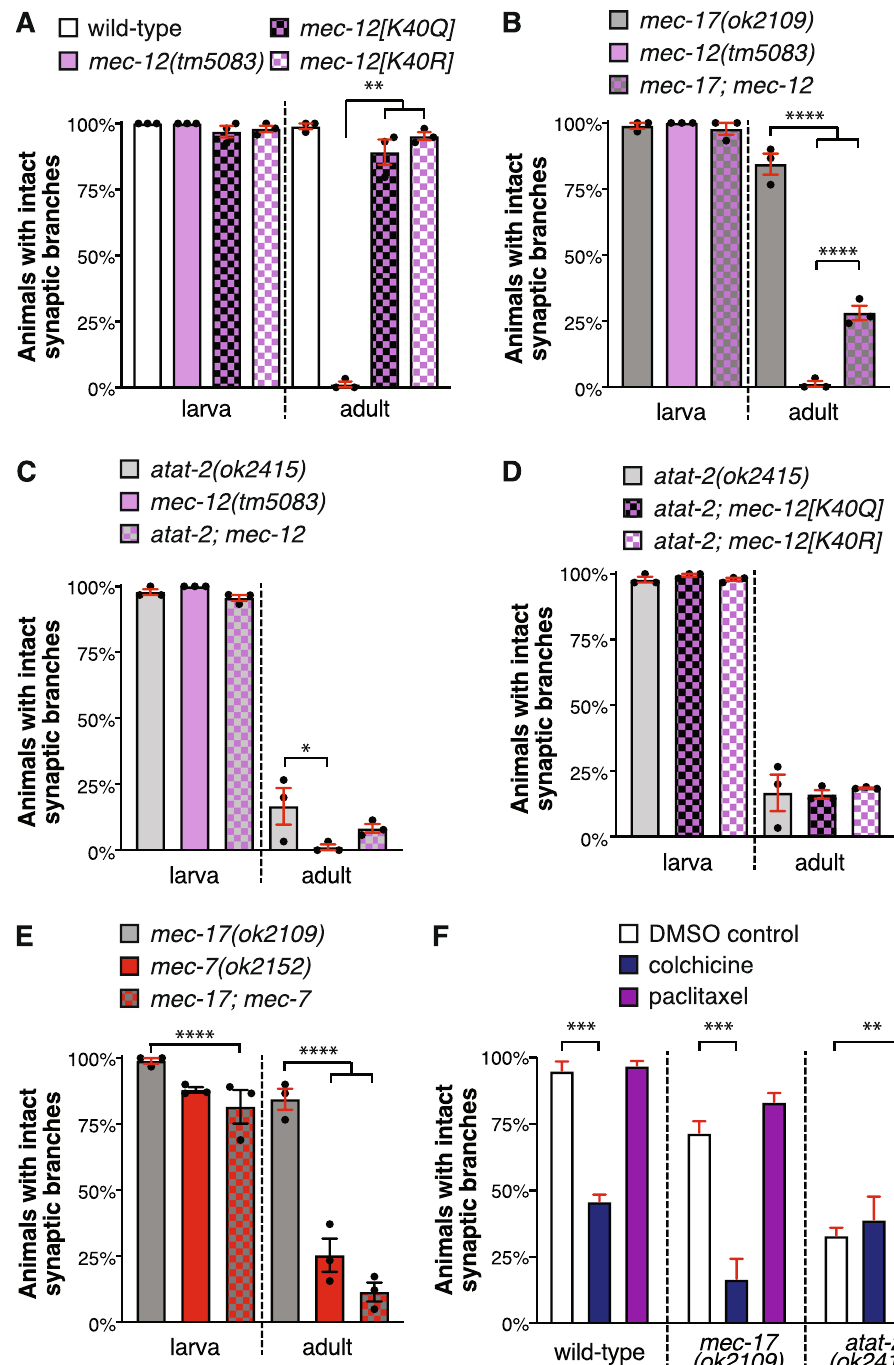
Figure 5. MEC-17 and ATAT-2 function independently from MEC-12/α-tubulin acetylation in maintaining synaptic branch stability. ( a ) The proportion of animals displaying intact synaptic branches in mec-12(tm5083) , mec-12[K40Q] , mec-12[K40R] mutants compared to wild-type. For each independent experiment n ≥ 27 (total n ≥ 87). ( b ) Quantification of animals with intact synaptic branches in mec-17(ok2109) and mec-12(tm5083) single and double mutant animals. For each independent experiment, n ≥ 29 (total n ≥ 89). ( c ) Quantification of animals with intact synaptic branches in atat-2(ok2415) and mec- 12(tm5083) single and double mutant animals. For each independent experiment, n ≥ 23 (total n ≥ 80). ( d ) The percentage of intact synaptic branches in animals carrying the atat-2(ok2415) mutant alone, or in combination with the mec-12[K40Q] or mec-12[K40Q] mutations . For each independent experiment n ≥ 29 (total n ≥ 89). ( e ) Quantification of animals with intact synaptic branches in mec-17(ok2109) and mec-7(ok2152) single and double mutant animals. For each independent experiment, n ≥ 30 (total n ≥ 90). Bars show mean ± SE; P values * < 0.05, ** < 0.01, *** < 0.001, **** < 0.0001 from one-way ANOVA with Tukey’s post-hoc test. ( f ) The percentage of wild-type, mec-17(ok2109) and atat-2(ok2415) animals (transgenic) with intact synaptic branches when treated with 1% DMSO (control, white bars), 0.5 mM colchicine (dark blue bars), or 10 μM paclitaxel (purple bars). For three independent experiments n ≥ 20 (total n ≥ 62). Bars show mean ± SE; P values ** < 0.01, *** < 0.001 from one-way ANOVA with Tukey’s post-hoc